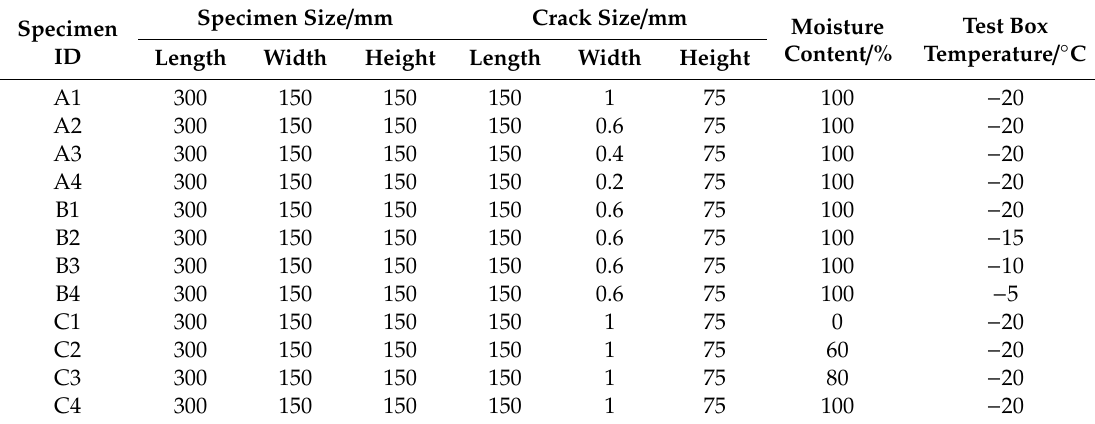
Table 2. Test conditions and specimen parameters for tests of frost-heave crack propagation.